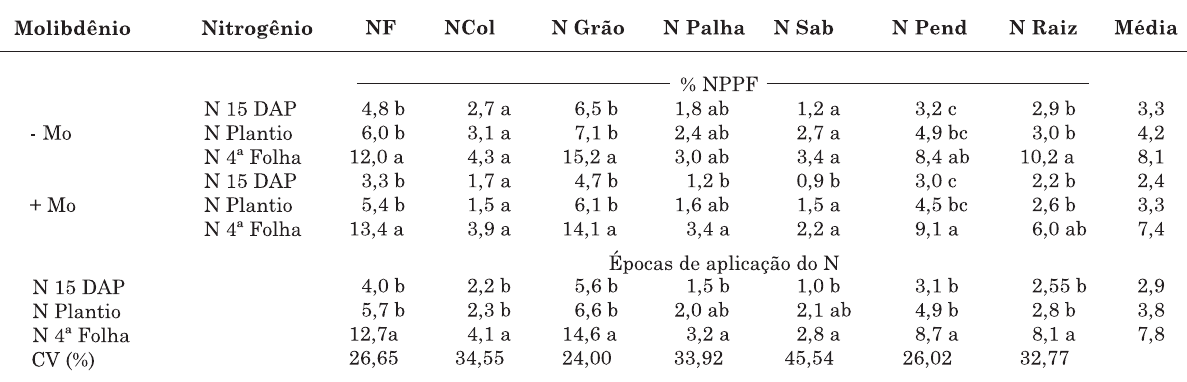
Quadro 4. Percentagem de N nos diversos componentes da planta proveniente do fertilizante (%NPPF), na folha (NF), no colmo (N Col), no grão (N Grão), na palha do milho (N Palha), no sabugo (N Sab), no pendão (N Pend) e na raiz de milho (N Raiz), em função da época de aplicação de nitrogênio e do suprimento de Mo, em Coimbra -